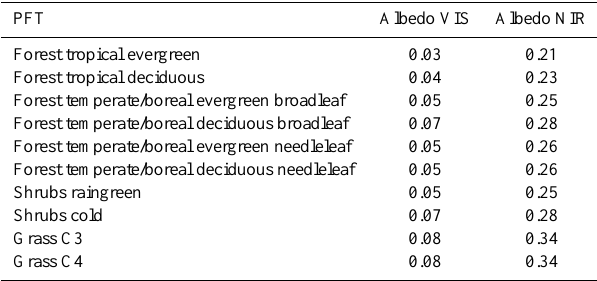
Table A1. α leaf values for VIS and NIR for each PFT derived from MODIS data